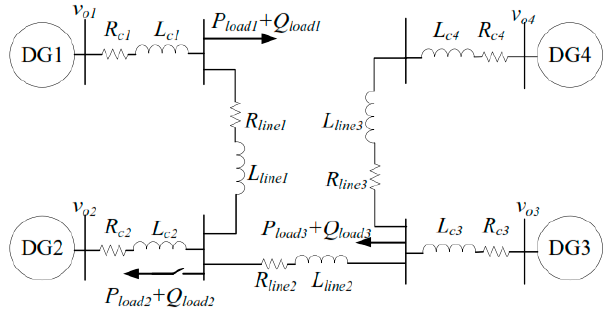
Figure 4. Test MG system.